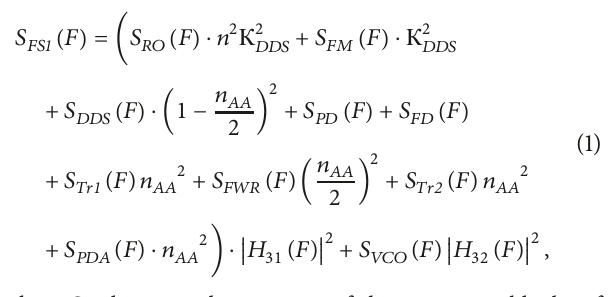
For the circuit shown in Figure 7, the mathematical model of noise characteristics is defined